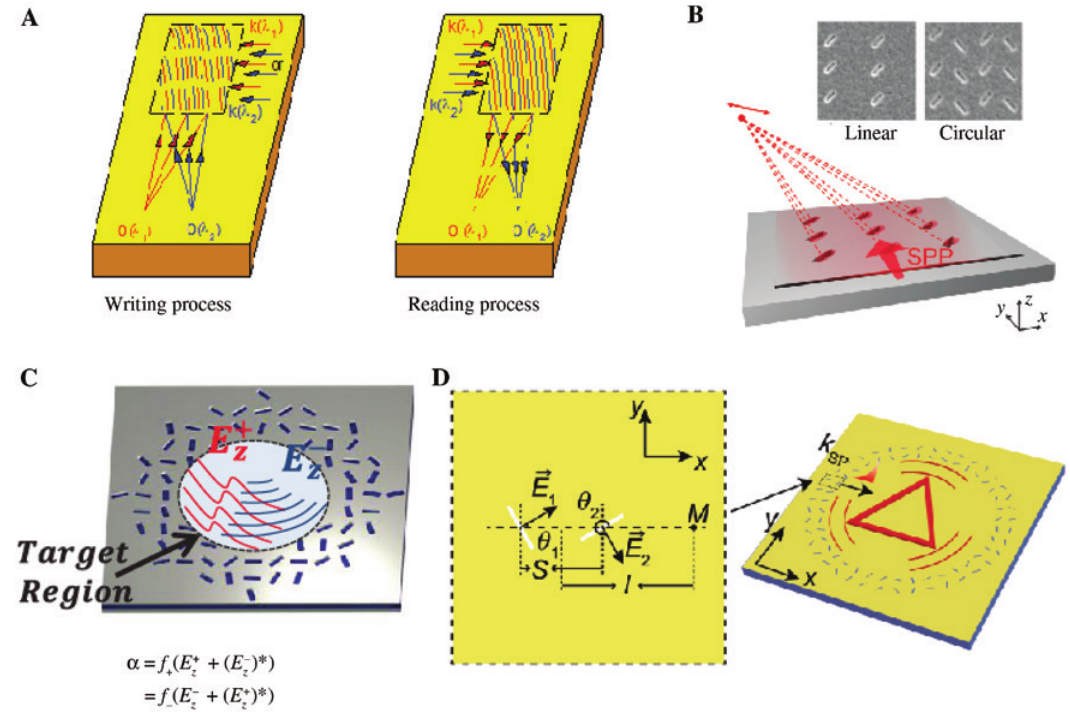
Figure 7: Surface wave holography. (A) Schematic of the writing and reading process of in-plane surface holography for multiple wavelengths [90]. (B) Design of the metasurface for the four-fold polarization controlled holographic multiplexing by coupling the SPPs to far-field radiation [36]. (C) Matching rule of surface holography by using the metasurfaces composed of nanoapertures to gain the independent spin-selective control of SPPs [37]. (D) Schematic views of the metasurface unit composed of a pair of nanoslits, for the simultaneous modulation of the amplitude and phase of SPPs for surface wave holography [91]. Reprint permission obtained from [36, 37, 90,